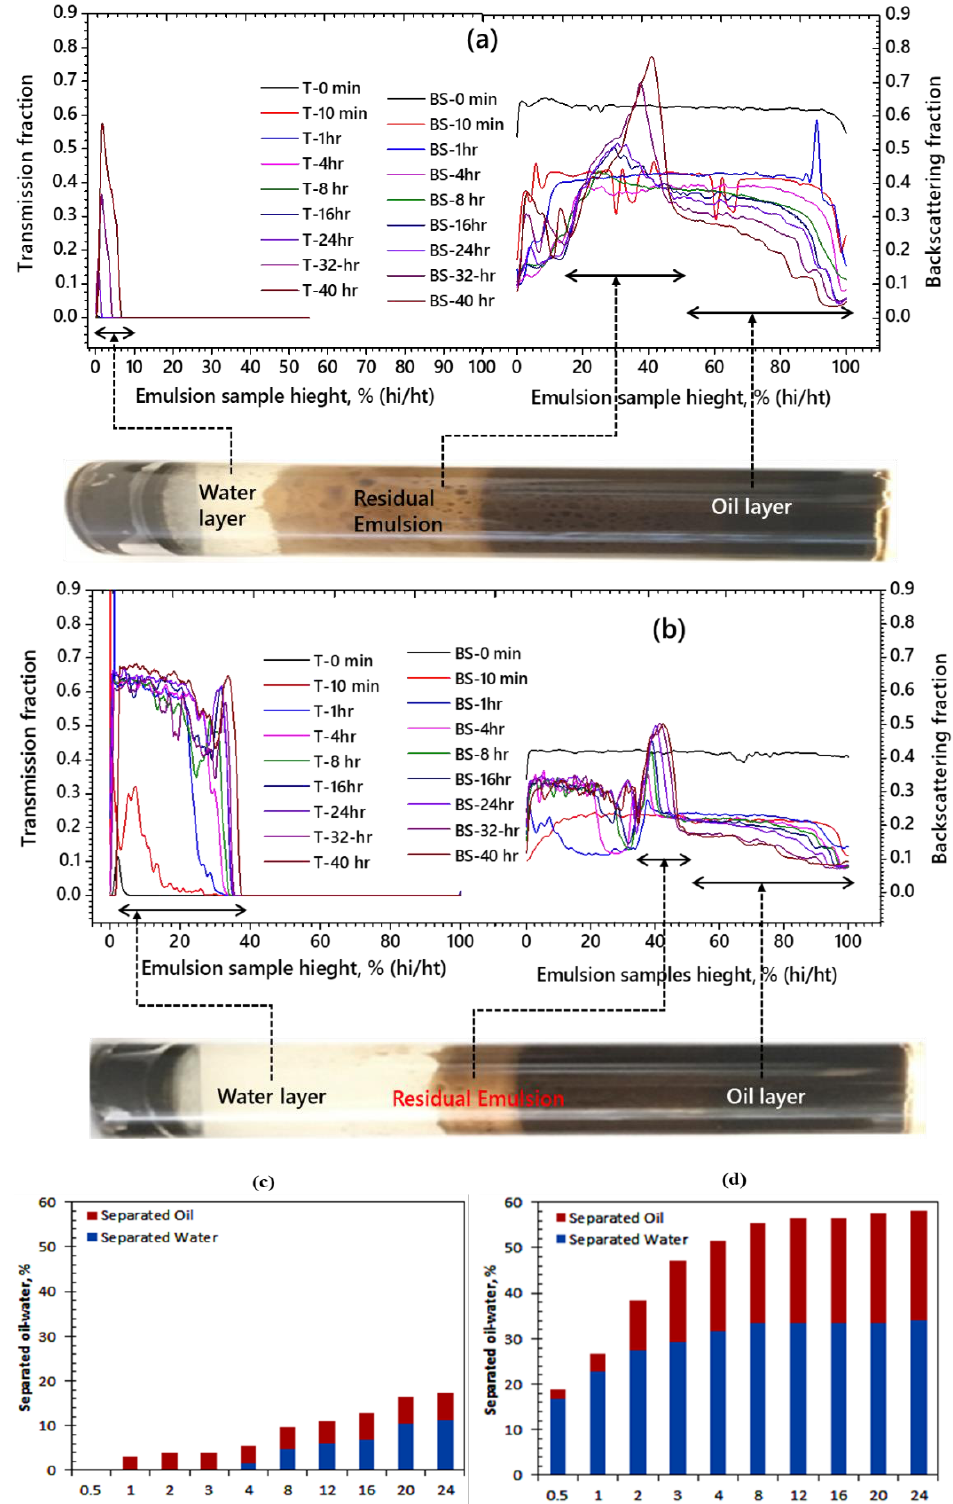
Figure 5. De-emulsification of ASP-produced emulsion ( a ) without TiO 2 nanoparticles and ( b ) with TiO 2 nanoparticles, and the percentage of oil/water separation ( c ) without TiO 2 nanoparticles and ( d ) with TiO 2 nanoparticles.